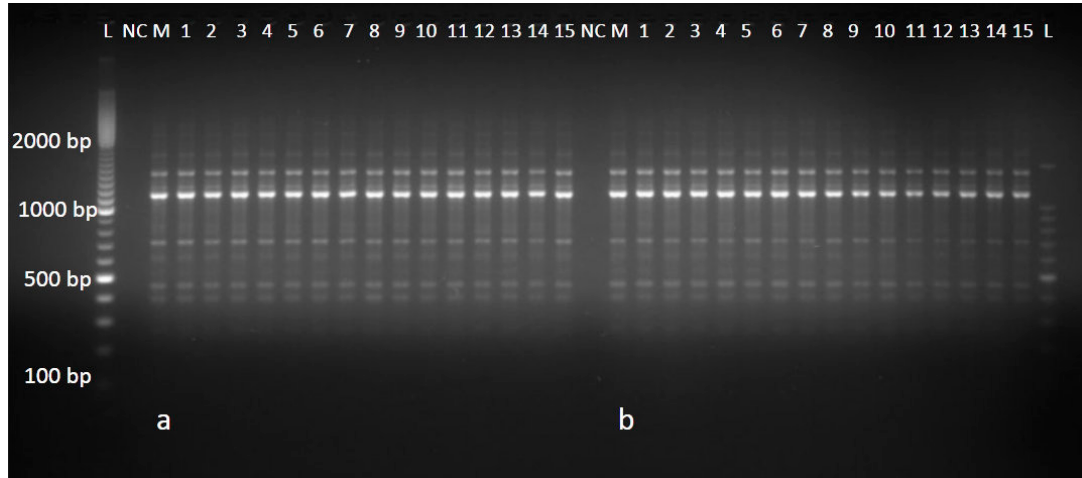
Figure 4. Analysis of the genetic fidelity of micropropagated H. Lupulus cv Cascade plants with their mother plant. RAPD fingerprinting profile obtained with OPX-03 primer of in vitro ( a ) and ex vitro ( b ) rooted and raised plants. Lane L: 100 bp Ladder (Promega, USA); Lane M: DNA banding patterns of mother plant; Lane 1–15: DNA banding patterns of in vitro propagated plants.